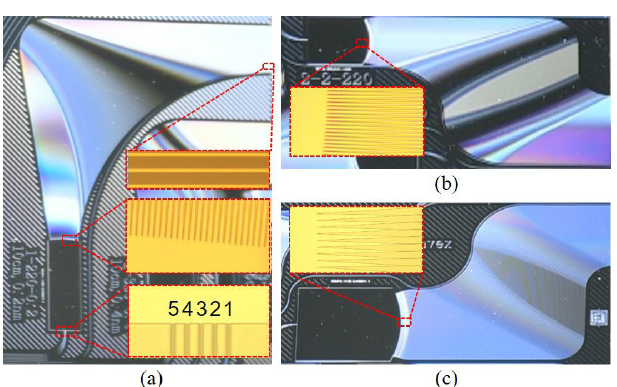
Figure 7. Photos of some fabricated devices: ( a ) WSL2, ( b ) WG lens, ( c ) WSL4. The insets are microscope images of the device parts. (5 4 3 2 1) There are five input ports in WSL2.